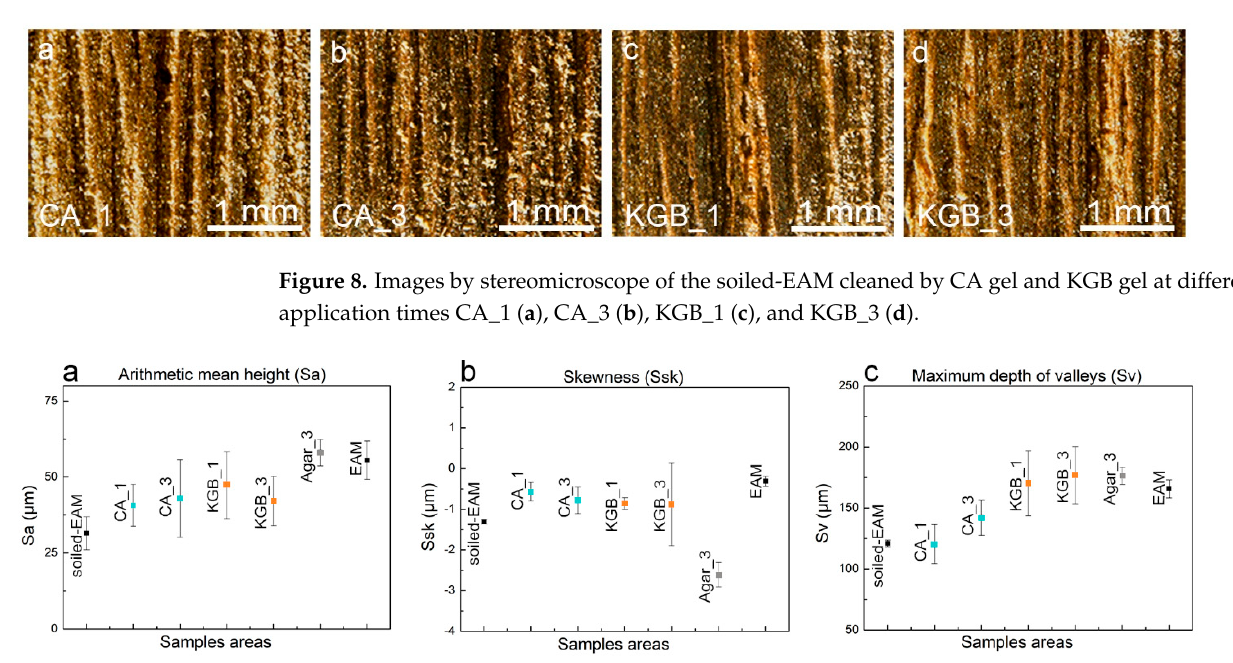
Figure 7. 3D heat maps of soiled-EAM ( a ) cleaned by CA_3 ( b ) and KGB_3 ( c ). The colour range represents the different heights (in microns) of the details present on the sample surface.